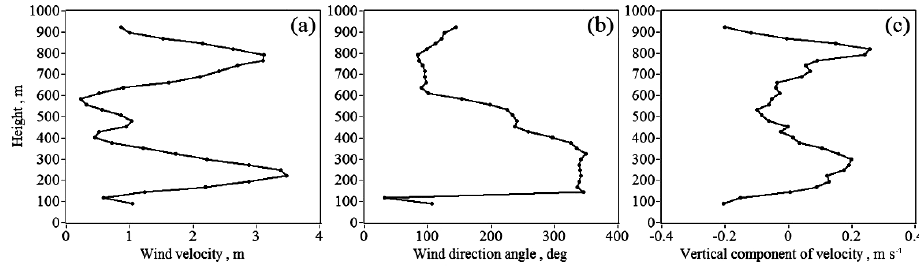
Figure 6. Vertical profiles of the wind speed (a) , the wind direction angle (b) and the vertical component of the wind vector (c) taken from the data of Fig. 4 (these profiles were measured at 14:31LT).